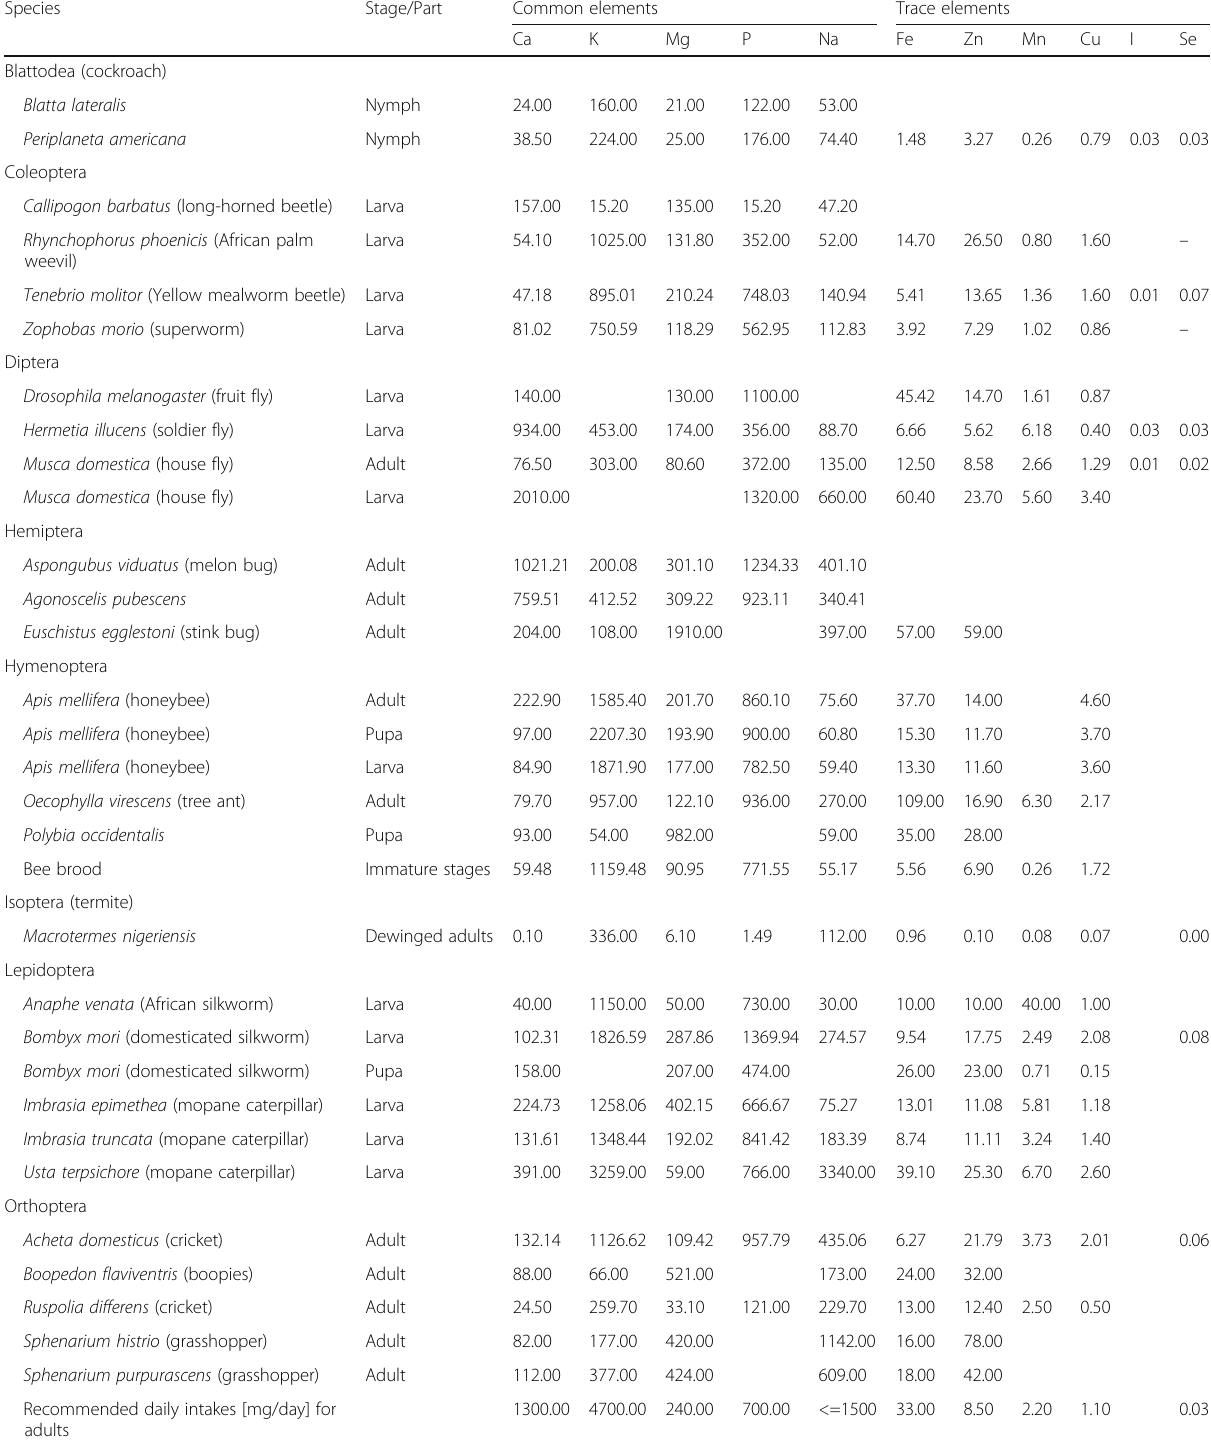
Table 3 Mineral compostion [mg/100 g] (dry weight)